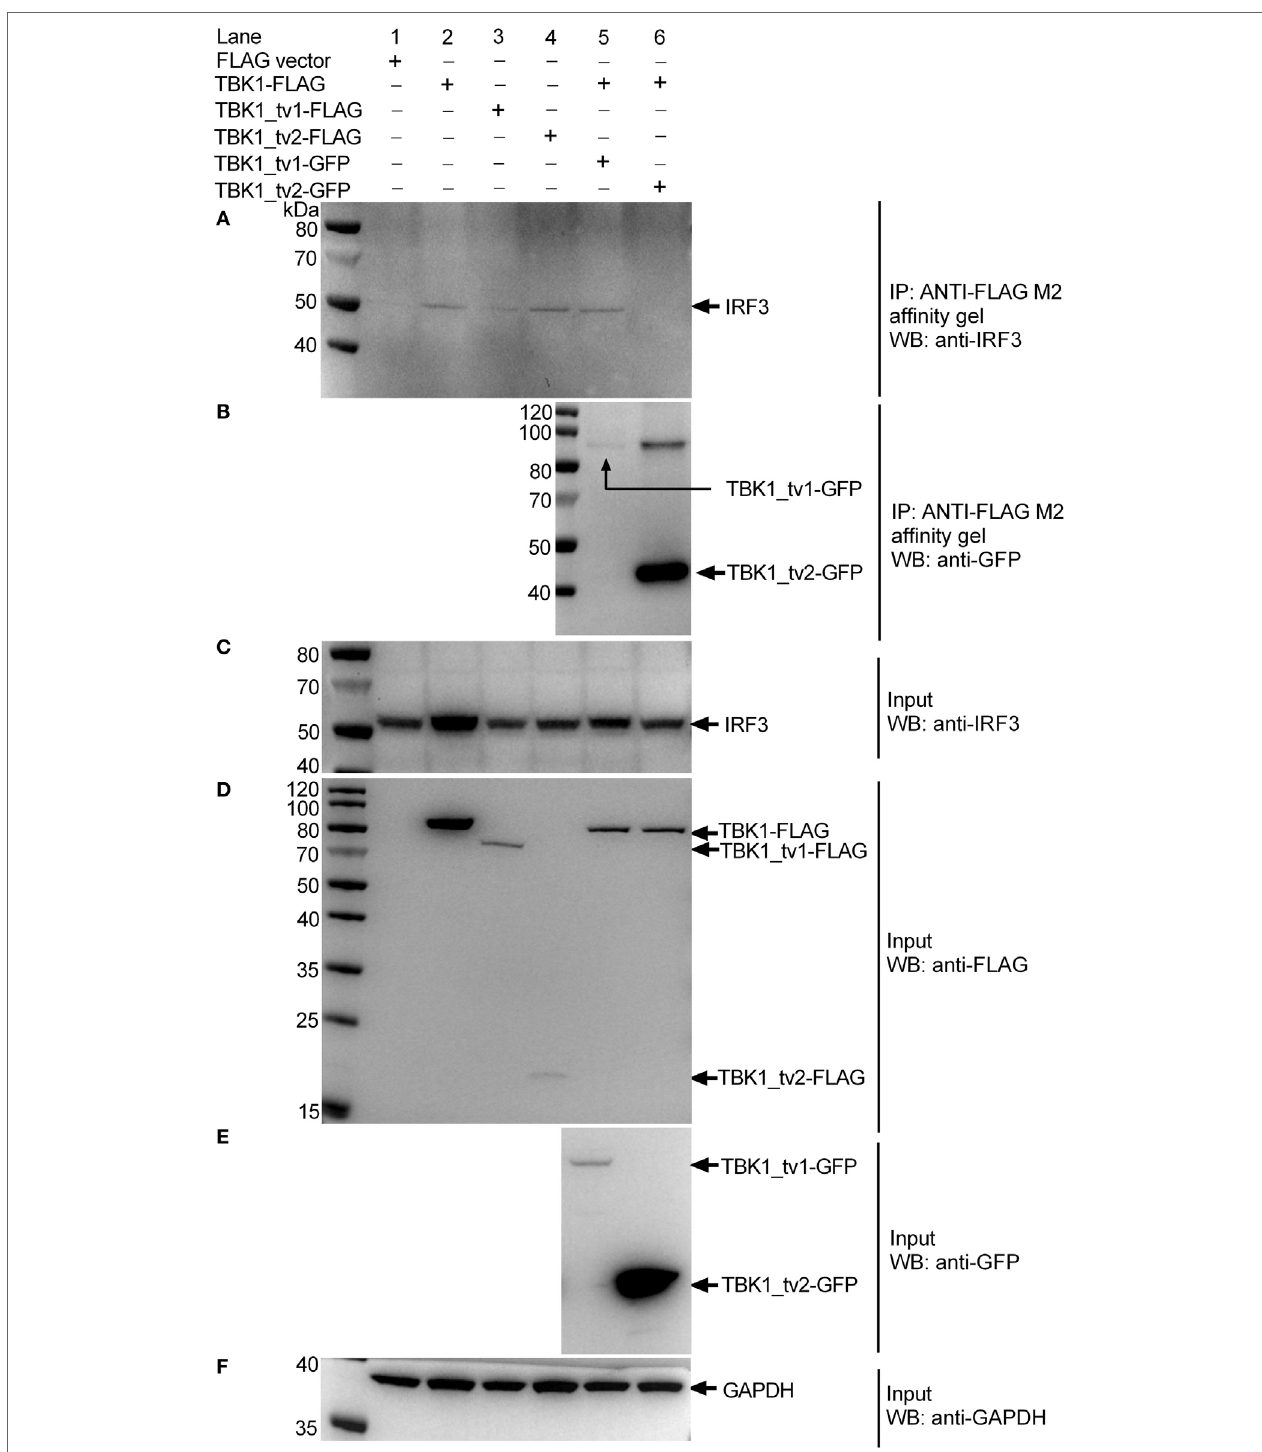
FigUre 8 | TANK-binding kinase 1 (TBK1) isoforms associate with TBK1 and IRF3 to disrupt TBK1-IRF3 interaction in epithelioma papulosum cyprini (EPC) cells infected with spring viremia of carp virus (SVCV). EPC cells seeded in 25 cm 2 cell culture flask were transfected with various indicated plasmids. After 24 h post transfection, the cells were infected with SVCV at a multiplicity of infection of 1. Another 24 h later, cell lysates were immunoprecipitated with anti-FLAG antibody (covalently conjugated to agarose beads) and immunoblotted with anti-IRF3 (a) or anti-GFP (B) antibody. The input proteins were also analyzed by immunoblotting with anti-IRF3 (c) , anti-FLAG (D) , anti-GFP (e) , or anti-GAPDH (F) antibody.